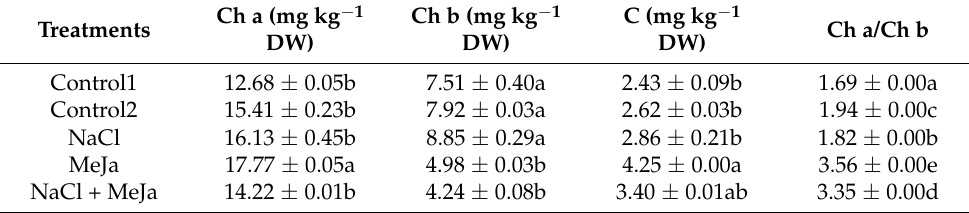
Table 7. The content of chlorophyll a (mg kg − 1 DW), chlorophyll b (mgk − 1 DW), and carotenoids (C) (mg kg − 1 DW) in the leaf tissues of C. maritimum under the different treatments (Control1, Control2, NaCl, MeJa, NaCl + MeJa), ( n = 10). Columns with different letters (a, b, c, d, e) for each variable differ significantly according to Tukey’s test ( p <